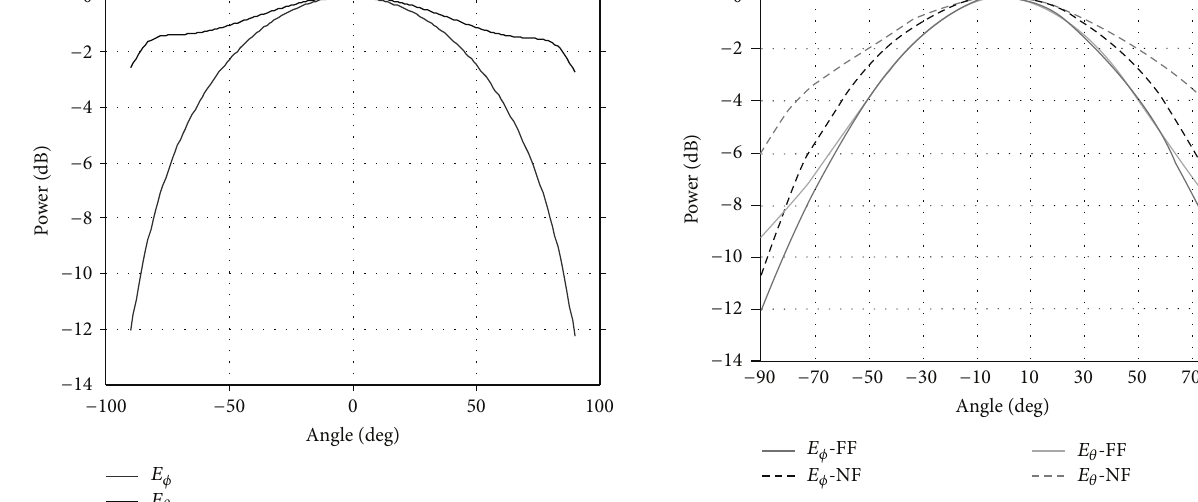
Figure 8: Comparison of far field (FF) and near field (NF) pattern of circular waveguide at 𝑟 = 𝐷 2 /𝜆